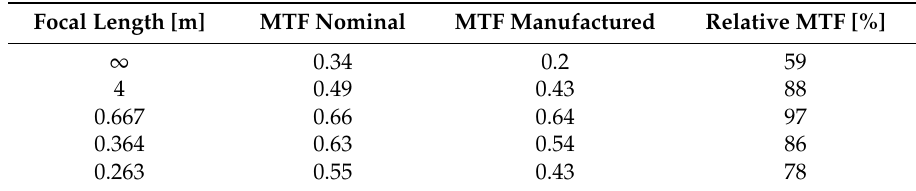
Table 2. Modulation transfer function (MTF) of the manufactured optics compared with the nominal design (central field, evaluated at 40 cyc/mm).